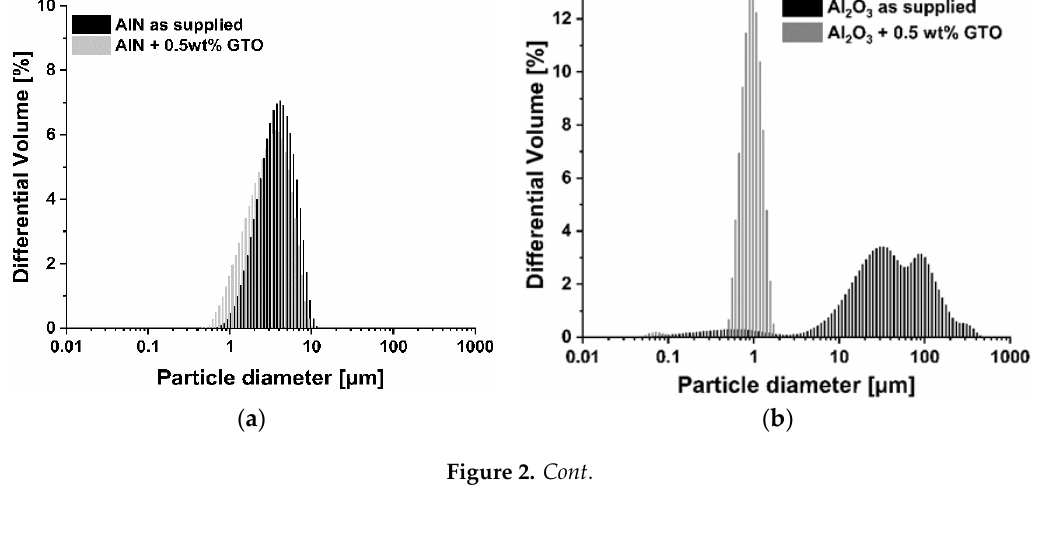
Table 3. Particle size distribution of powders with (+) and without (−) dispersing agent applied